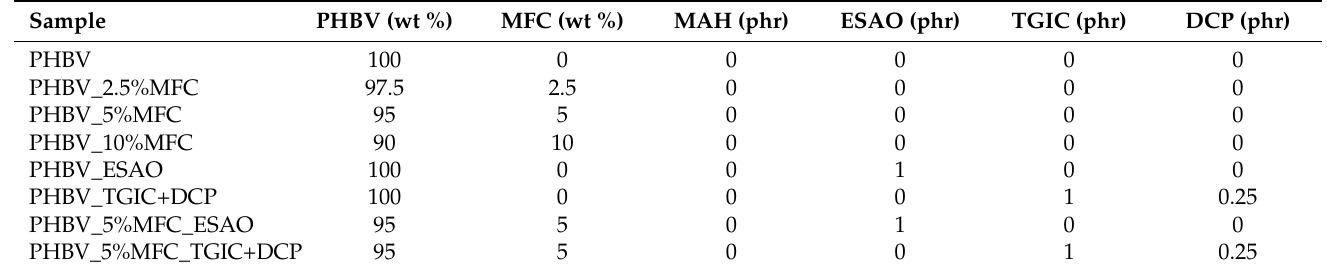
Table 1. Summary of compositions according to the weight content (wt %) of poly(3-hydroxybutyrate- co -3-hydroxyvalerate) (PHBV) and microfibrillated cellulose (MFC) in which epoxy-based styrene- acrylic oligomer (ESAO), triglycidyl isocyanurate (TGIC), and dicumyl peroxide (DCP) were added as parts per hundred resins (phr) of green